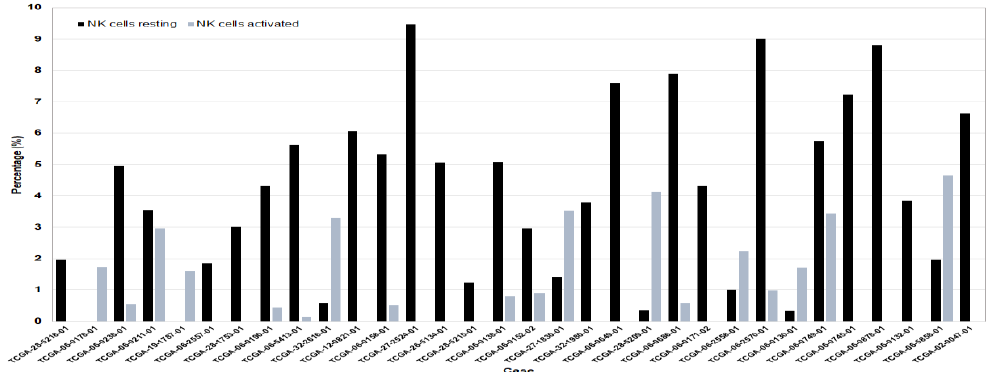
Figure 5. Proportion of NK cells identified in GBM TCGA samples. Deconvoluted RNASeq transcriptional data into resting and activated NK cells plotted as a percentage of these cells’ presence in individual TCGA samples for which p <